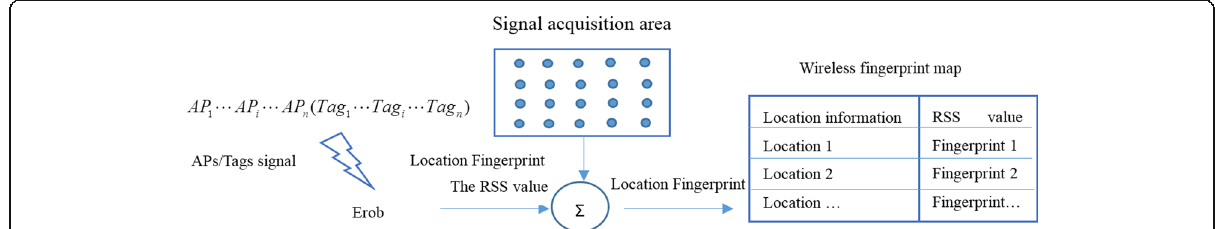
Fig. 1 Based on the fingerprint positioning technology of Erob offline stage. Offline stage: When the Erob enters the wireless coverage (APs/Tags)